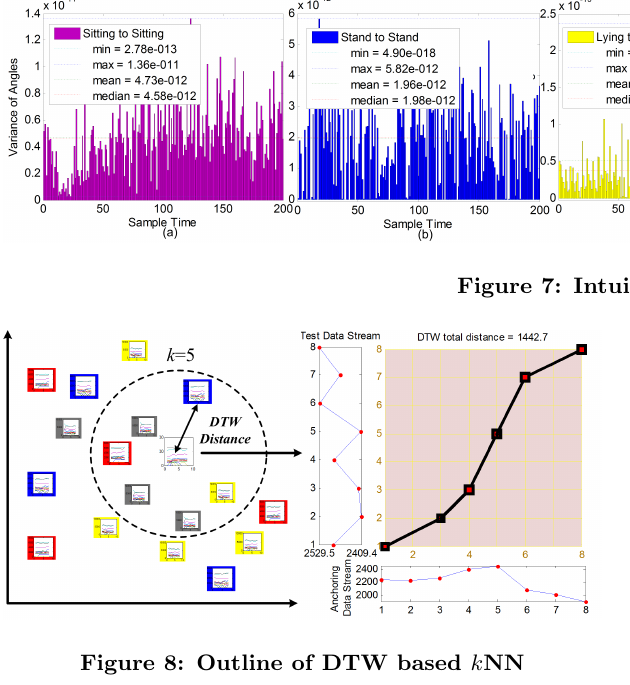
Figure 8: Outline of DTW based k NN